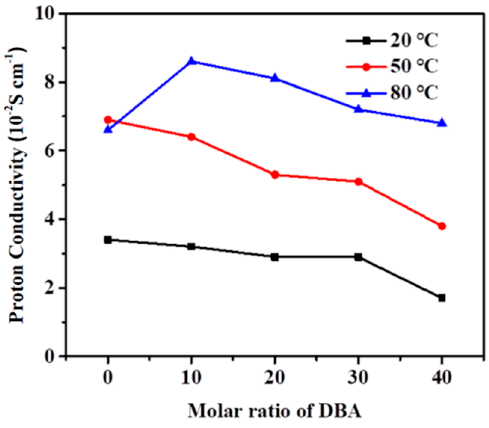
Table 3. The proton conductivity, methanol permeability, and selectivity of CSPEN-60-DBA-x at different temperatures.